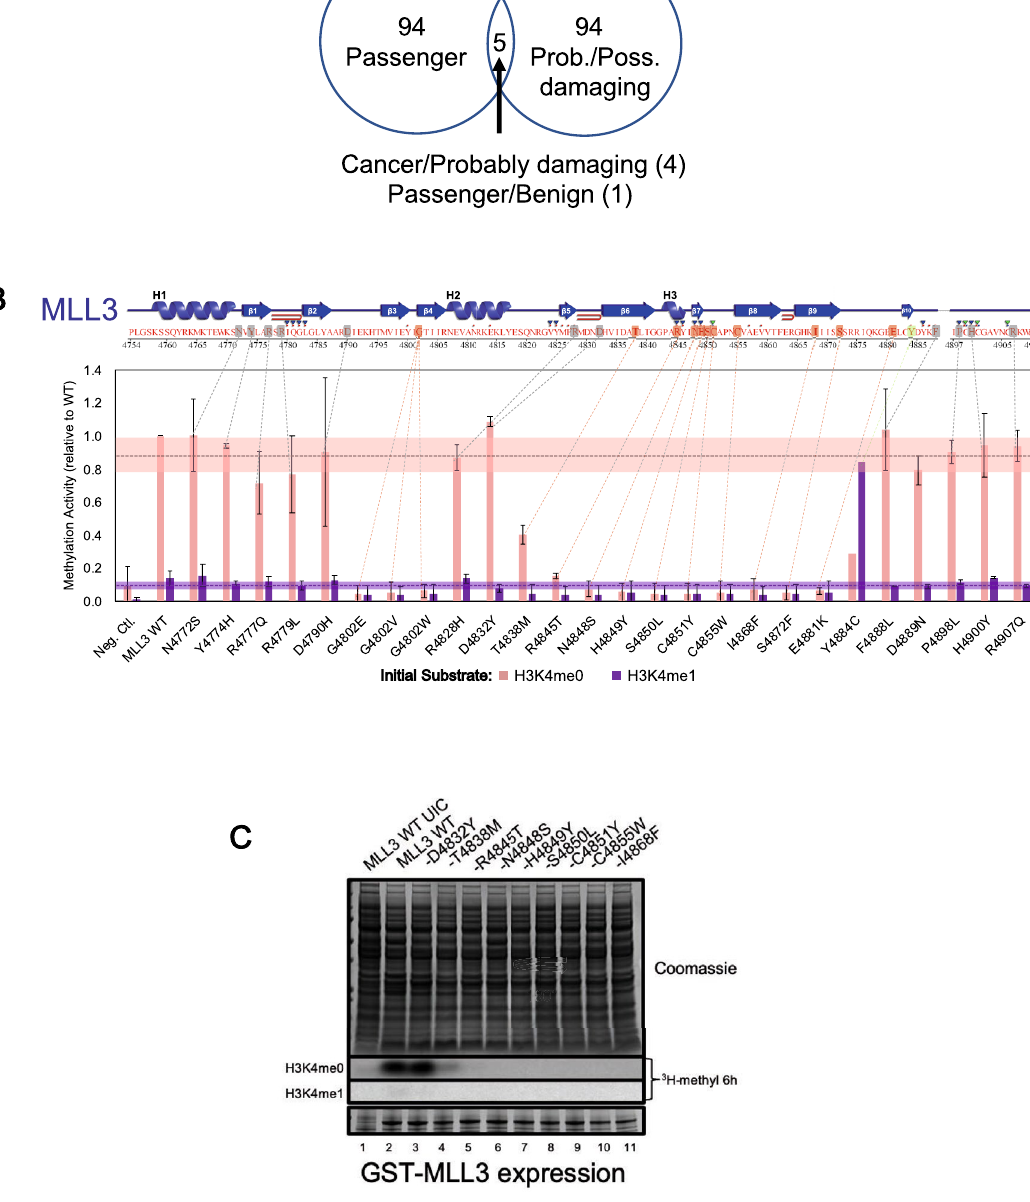
Figure 2. Parallel Functional Annotation (PFA) of cancer-associated histone methyltransferase variants of uncertain significance (VUS). ( A ) Venn diagram of FATHMM and PolyPhen-2 functional prediction of Mixed Lineage Leukemia (MLL) VUS: 5 of 99 mutations had overlapping predictions. ( B ) Top, catalytic SET domain secondary structure map from PDBsum based on PDB 5F59, amino acids 4754–4911. Shown are alpha helices (H1-3), beta sheets (β1-10) beta hairpin sturns (red coloured hairpin sturns), and ligand/metal binding residues: H3/SAH binding (red filled square), SAH binding (blue filled triangle), zinc ion binding (blue filled square/green filled triangle). Bottom, representative PFA of MLL3 VUS mutations by scintillation counting. Quenching was after 30 min with data normalized against WT. Pink and purple, assays initiated with H3K4me0, H3K4me1. Dashed lines and corresponding shaded regions, average and standard deviation (1σ), respectively, for all variants with activity > 50% of WT. Error bars, standard deviation from 2 independent experiments. ( C ) Representative results from PFA for MLL3 VUS mutations by fluorography of SDS-PAGE. Upper , Coomassie- stained gel of quenched enzymatic reactions; middle , signal from reactions with H3K4me0 (unmethylated) or H3K4me1 (monomethylated) peptides; bottom , expression of MLL3 variants by Coomassie-stained SDS-PAGE. Assays were as described for Fig. 1, limiting the recombinant subunits required for full enzymatic activity 31–33 to minimize activity variation from differing MLL expression. Rates of monomethylation and dimethylation were determined using unmodified or monomethylated substrates. Activity depended on recombinant expression (no activity in uninduced control, UIC, lane 1). Lanes 2–11 show representative wild-type (WT) and variant MLL3 complexes, demonstrating that activity variation cannot be explained by differential expression. An uncropped version of Fig. 2C is shown in Fig.